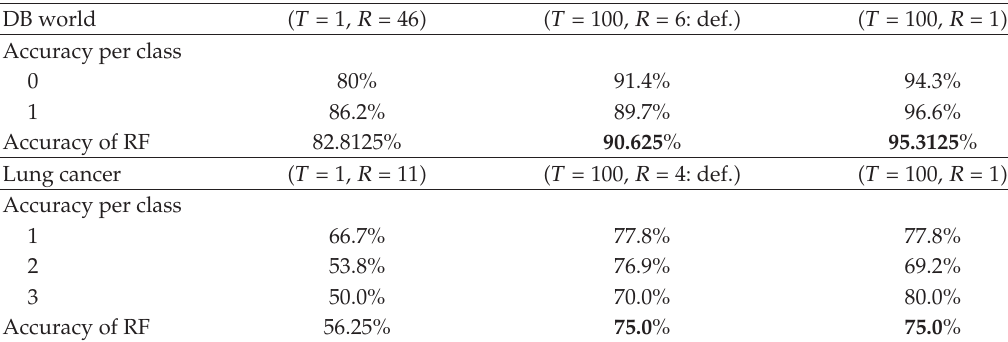
Table 12: The accuracy of trial random forests (cid:6) RF (cid:7) for each class with di ff erent